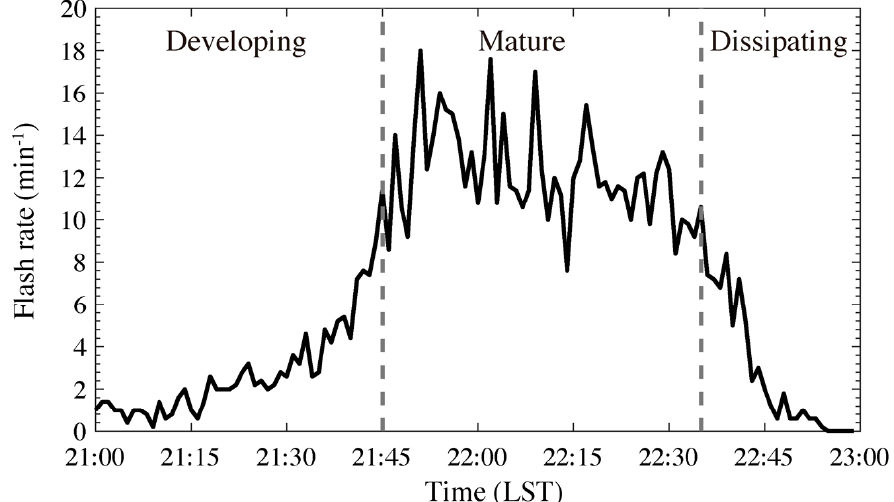
Figure 2. The flash rate observed during a thunderstorm from 21:00 to 23:00 on 10 July 2022, in Nanjing. The developing, mature, and dissipating stages are partitioned by the two vertical dashed lines.